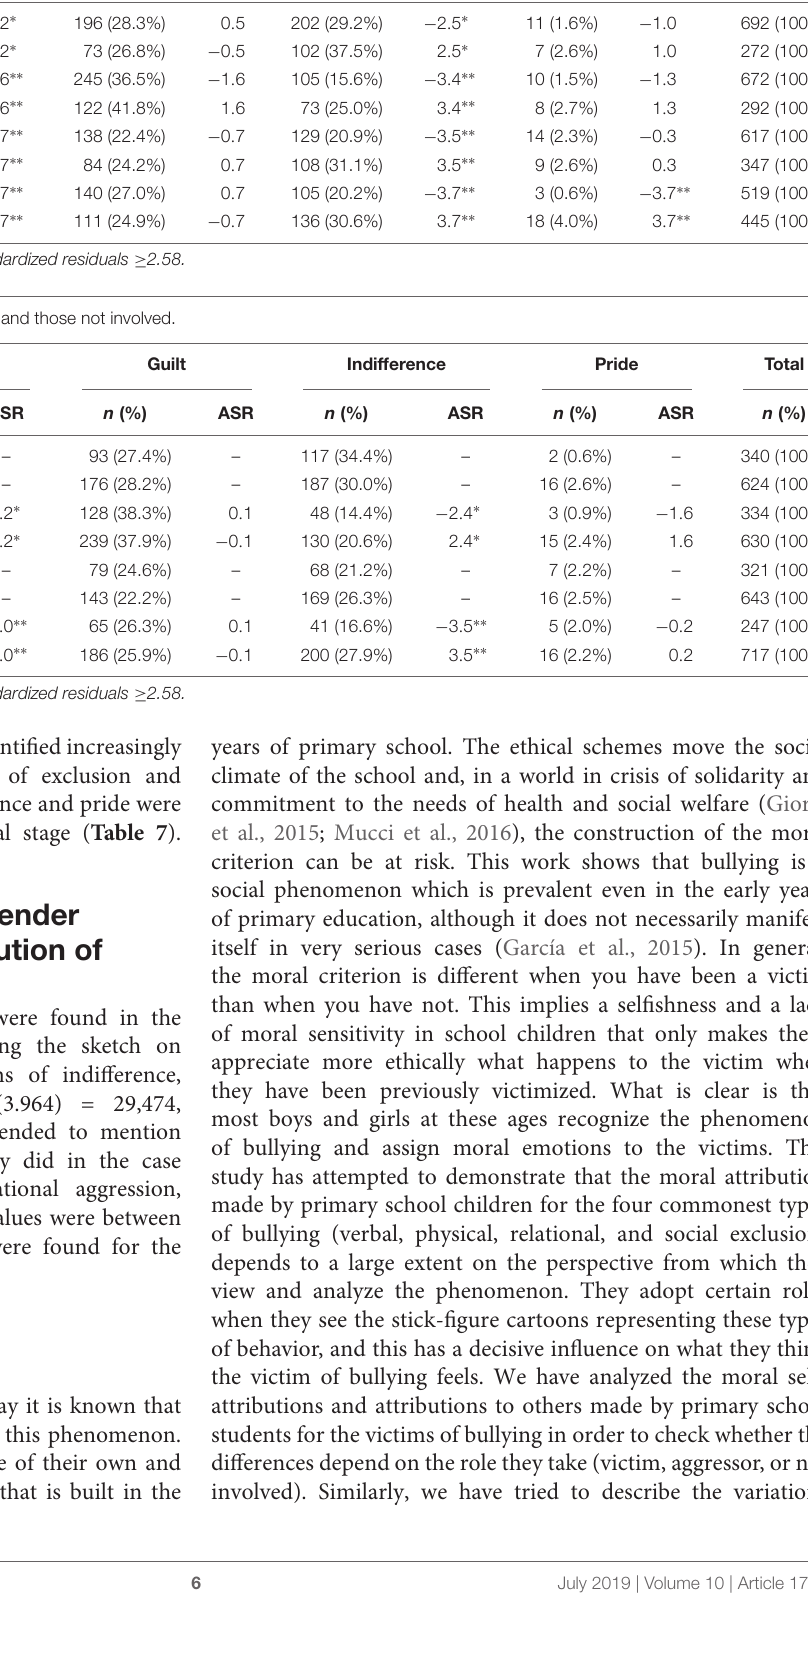
TABLE 5 | Percentages of moral self-attribution of aggressors and those not involved. Shame Guilt Indifference Pride Total n (%) ASR n (%) ASR